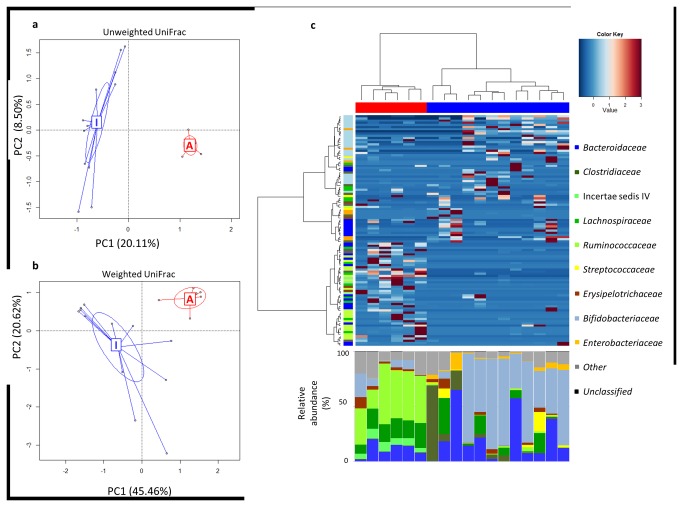
Analysis of 16S rDNA gene sequences from stool microbiota separates breast-fed infants and adults.Unweighted (a) and weighted (b) UniFrac PCoA of the fecal microbiota from breast-fed infants (blue) and adults (red). c, Hierarchical Ward-linkage clustering based on the Spearman correlation coefficients of OTU proportion. OTUs were filtered for subject prevalence of at least 20%. Subjects are clustered in the top of panel and color-coded as in a. OTUs are clustered by the vertical tree and color-coded by family assignment. 107 OTUs confidentially classified to family level are visualized. In the bottom panel the relative abundance (%) of family-classified microbiota is shown.